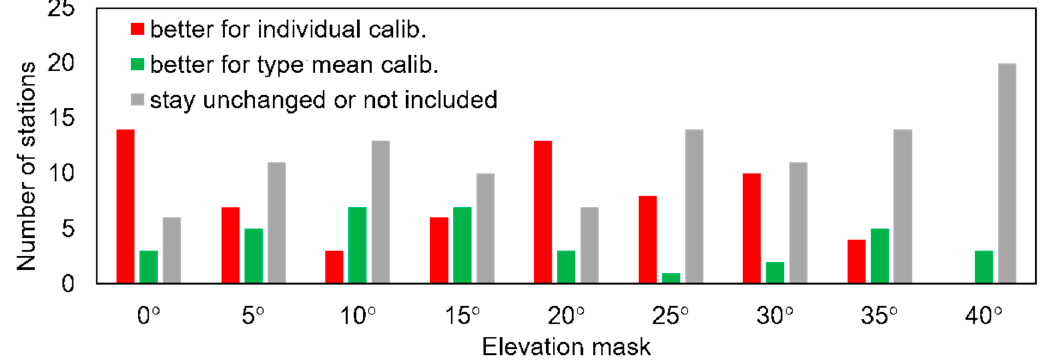
Figure 3. Height repeatability depending of applied elevation mask.